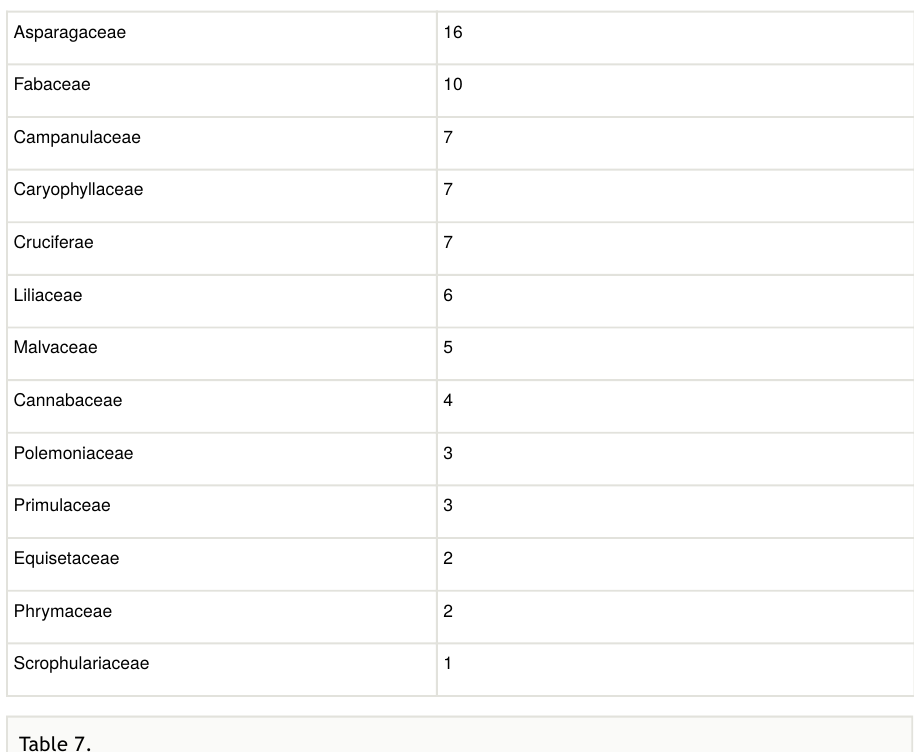
Table 7. The number of individuals in each species of tree in Liangshui National Natural Reserve. (Species names are checked by